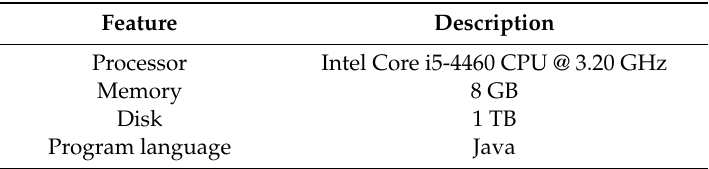
Table 3. Performance evaluation environment.